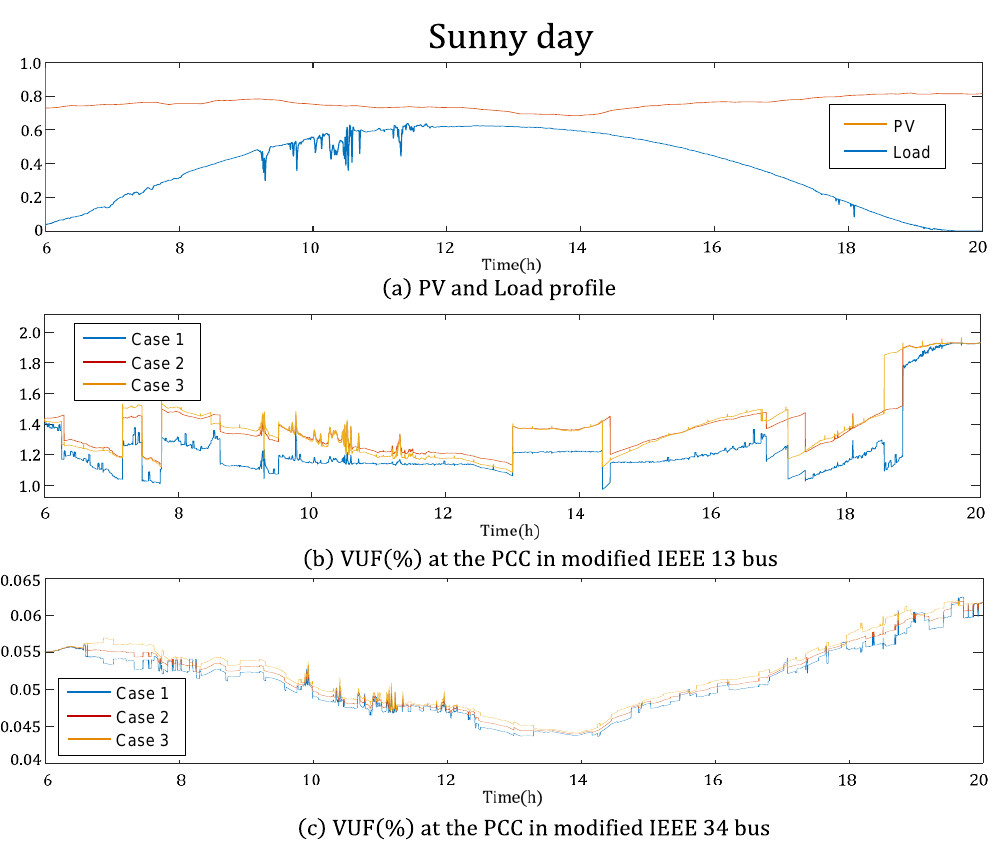
Figure 10. PV and load profile and 𝑉𝑈𝐹(%) at the PCC for a sunny day.